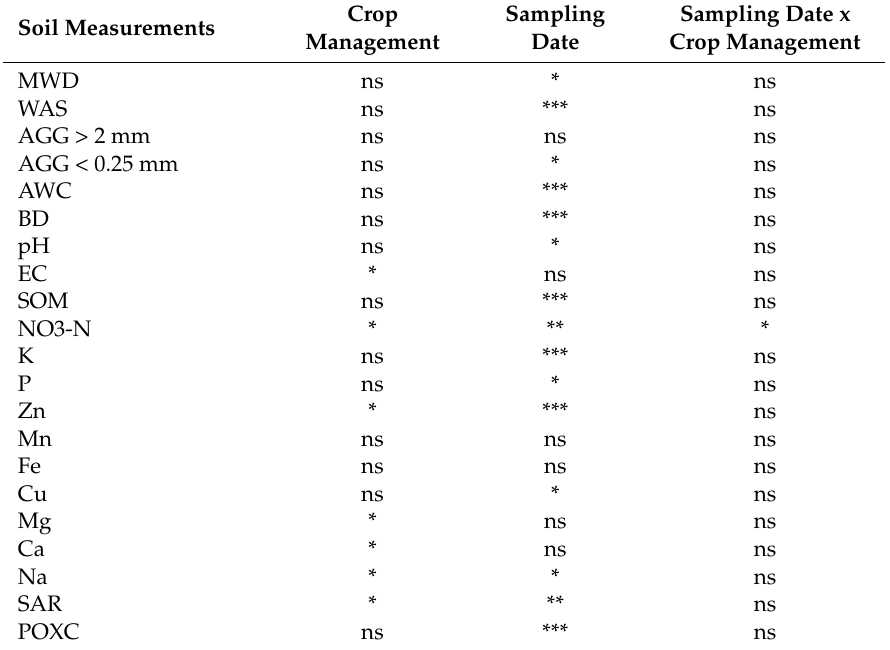
Table 2. ANOVA results of treatment effects and their interaction for soil measurements. Crop Soil Measurements